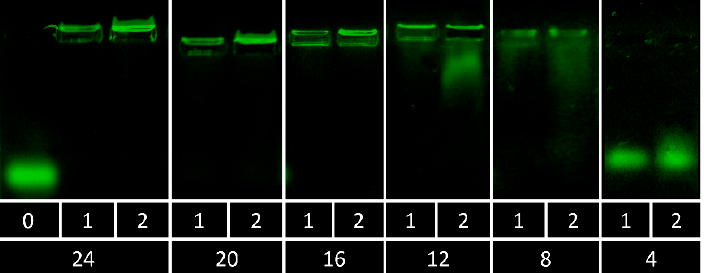
Figure 1. Gel electrophoresis data for PEI (1) and AKX-182 (2) complexes with (TCAG)n DNA (last row–length of the DNA), “0”–free DNA (similar blots were observed irrespective of DNA length). DNA concentration was 2.5 µM (calculating on DNA chains), N/P ratio = 20.